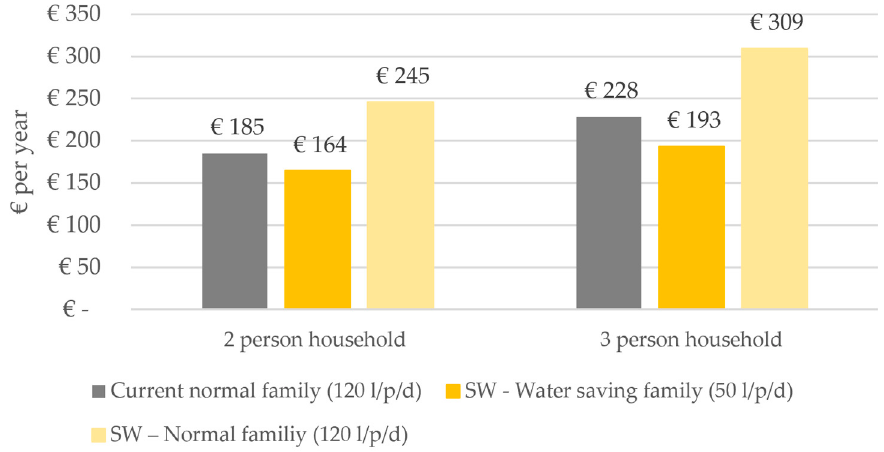
Figure 9. Annual prices for different households in the combined scenario SW-extreme and demographic low. Table 8. Sustainability of centralised system in SW-extreme scenario.